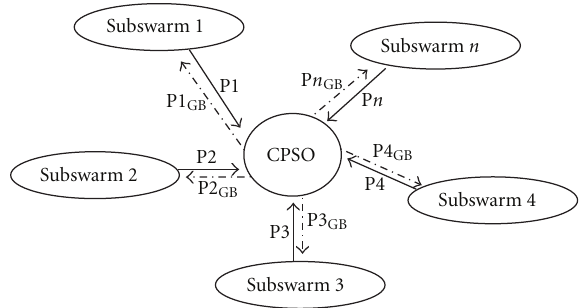
Figure 1: The schematic diagram of information sharing in CPSO.